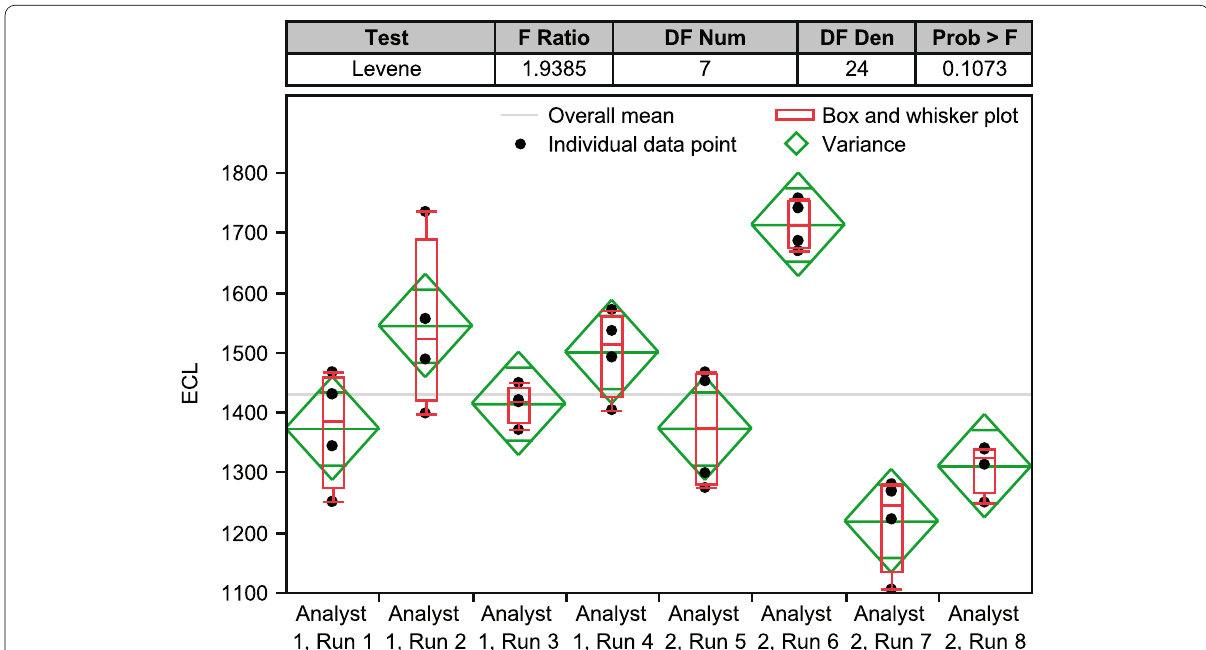
Fig. 3 Plot of negative control ECL values by run and analyst. Box and whisker plot of 25th and 75th percentiles, median, minimum, and maximum is presented. DF Den, denominator degree of freedom; DF Num, numerator degree of freedom; ECL, electrochemiluminescence; Prob, probability S / N , signal to noise